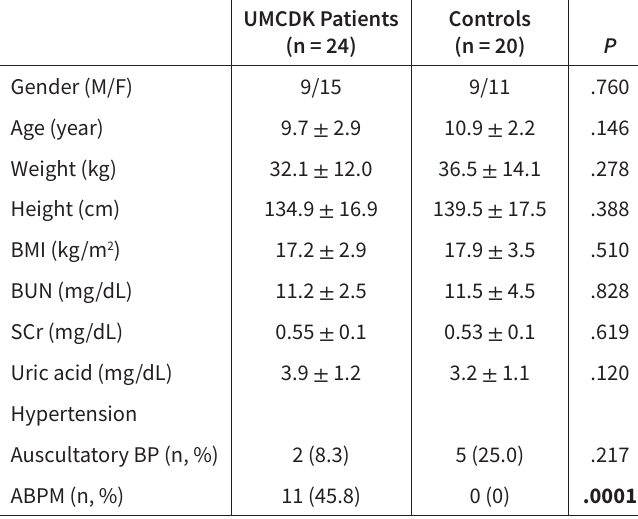
Table 1. Clinical and Laboratory Data of the Patients with UMCDK